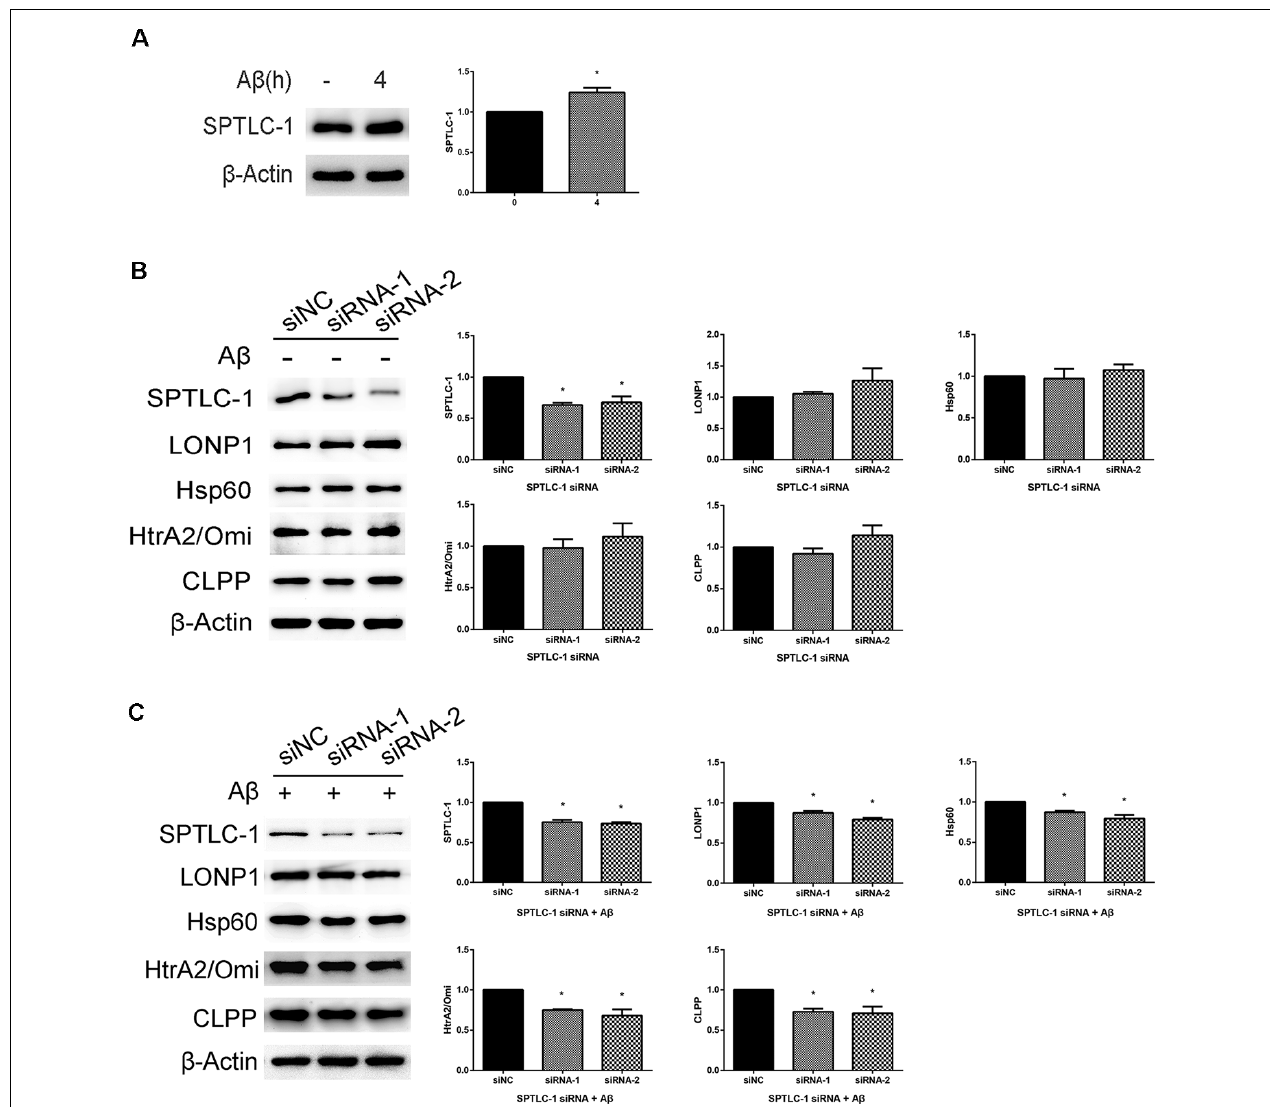
FIGURE 4 | Inhibition of the sphingolipid biosynthesis pathway by serine palmitoyltransferase long chain subunit 1 (SPTLC-1) siRNAs reduces the UPRmt reaction induced by A β 25–35 in SHSY5Y cells. (A) Western blot analysis of SPTLC-1 protein level in SHSY5Y cells treated with 20 µ M A β 25–35 for 4 h, quantification and β -Actin served as the internal control. The data are mean ± SEM ( n = 3, ∗ p < 0.05 vs. control group). (B) Western blot analysis of SPTLC-1 and UPRmt related proteins level in SHSY5Y cells transfected with scramble or SPTLC-1 siRNAs for 48 h, quantification and β -Actin served as the internal control. The data are mean ± SEM ( n =